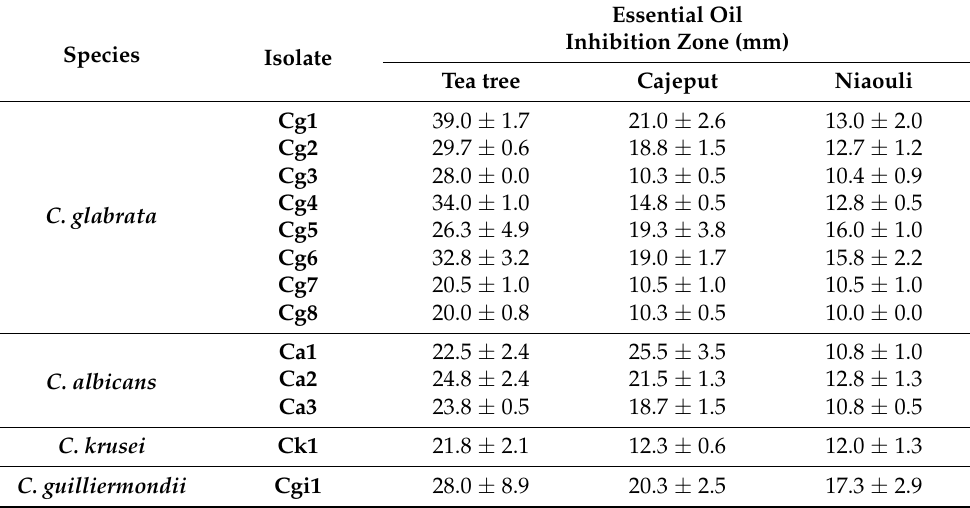
Table 2. Anti- Candida activity of essential oils on drug-resistant isolates evaluated through the disk-diffusion